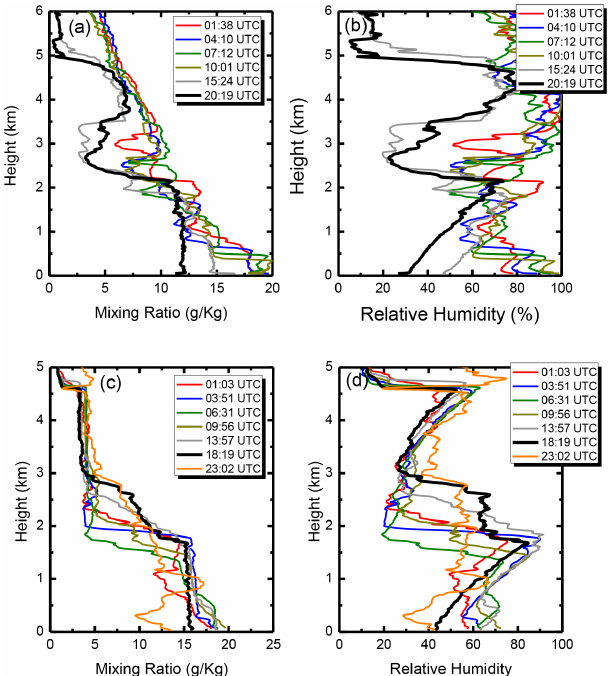
Figure 3. Water vapor mixing ratio and relative humidity profiles obtained from radiosondes launched at HUBC on (a–b) 29 July 2011 and (c–d) 22 July